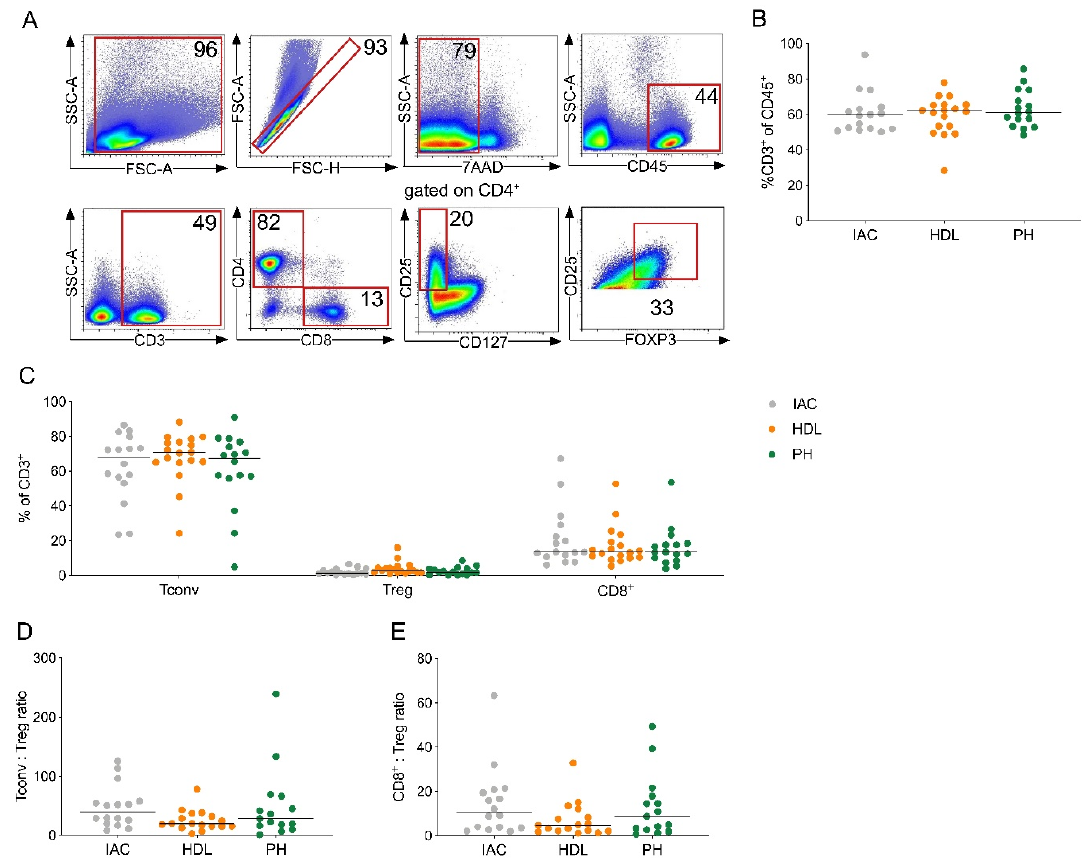
Figure 1. CD4 + T cells are the predominant T cell subset in pancreatic ductal adenocarcinoma (PDAC)-draining lymph nodes. ( A ) Representative flow cytometric gating strategy for the identification of T cells. Number indicates percentage of population per gate. SSC, side scatter; FSC, forward scatter. ( B ) Quantification of CD3 + T cells among all leucocytes (CD45 + ). ( C ) CD4 + Tconv cells (Tconv; CD3 + CD4 + ’not Treg’), regulatory T cells (Treg; CD3 + CD4 + CD8 - CD25 + CD127 - FOXP3 + ) and CD8 + T cells (CD8 + ; CD3 + CD4 - CD8 + ) as a percentage of CD3 + T cells in lymph nodes of the indicated location from patients with PDAC. ( D ) Ratio of CD4 + Tconv to Treg and ( E ) CD8 + T cells to Treg in lymph nodes. IAC, interaortocaval: lymph node around the abdominal aorta; HDL, hepatoduodenal ligament: lymph node along the hepatic artery and bile duct; PH, pancreatic head: lymph node from the posterior aspect of the pancreatic head. Each point represents data from one patient. Data, median. One-way ANOVA.